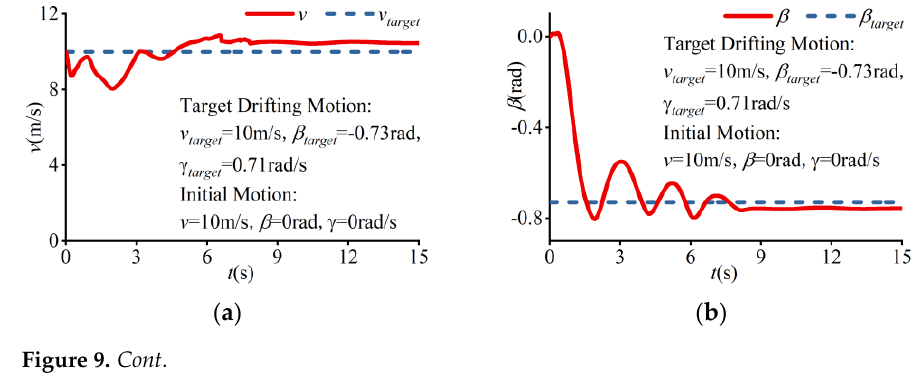
( f ) Figure 9. The simulation result with the initial motion as Group 3 in Table 3 to realize the target drifting motion as Group 2 in Table 2: ( a ) the variation curve of the velocity; ( b ) the variation cure of the sideslip angle; ( c ) the variation curve of the yaw rate; ( d ) the variation cure of the steering angle; ( e ) the variation curves of the TYDEX longitudinal slip ratios; ( f ) the position modification of the narrow tilting vehicle in the ground coordinates. ( a )